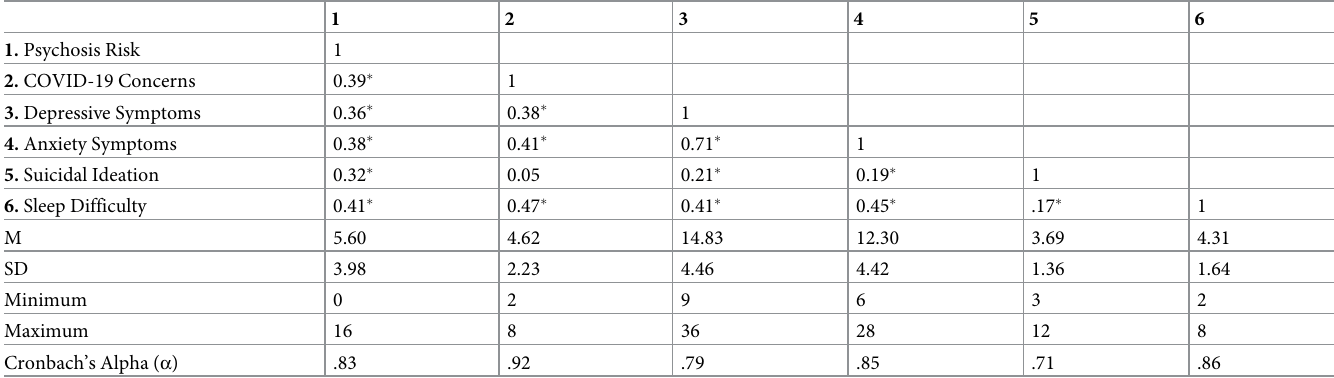
Table 2. Intercorrelation and descriptive statistics of continuous study variables.